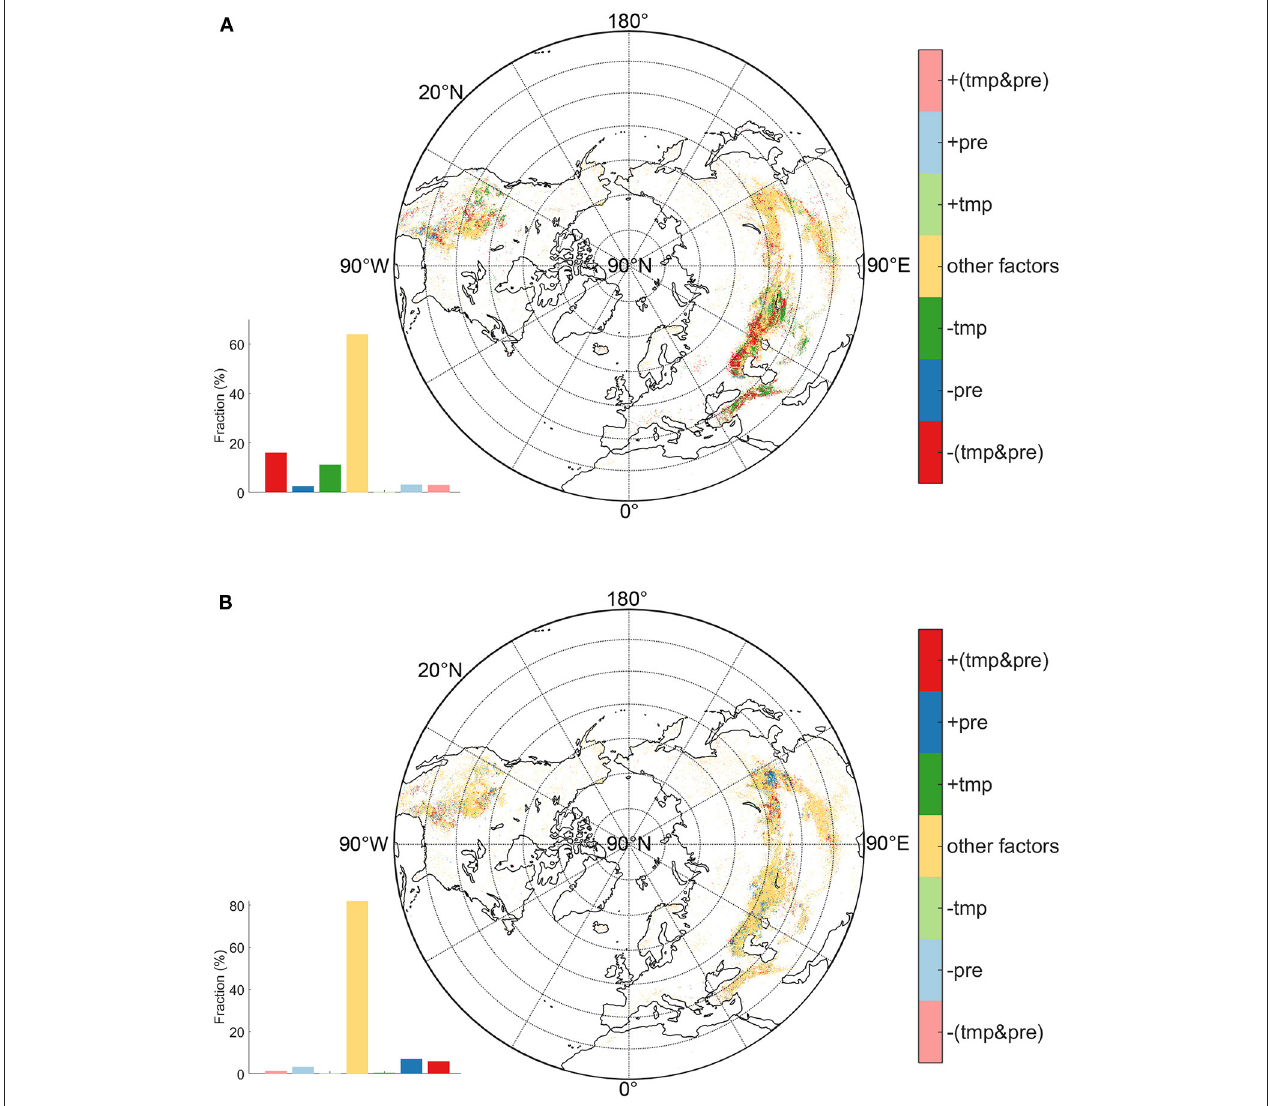
FIGURE 3 | The primary effects on SOS (A) and EOS (B) . The influencing factors includes temperature (tmp), precipitation (pre), the interaction of tmp and pre (tmp&pre), and other